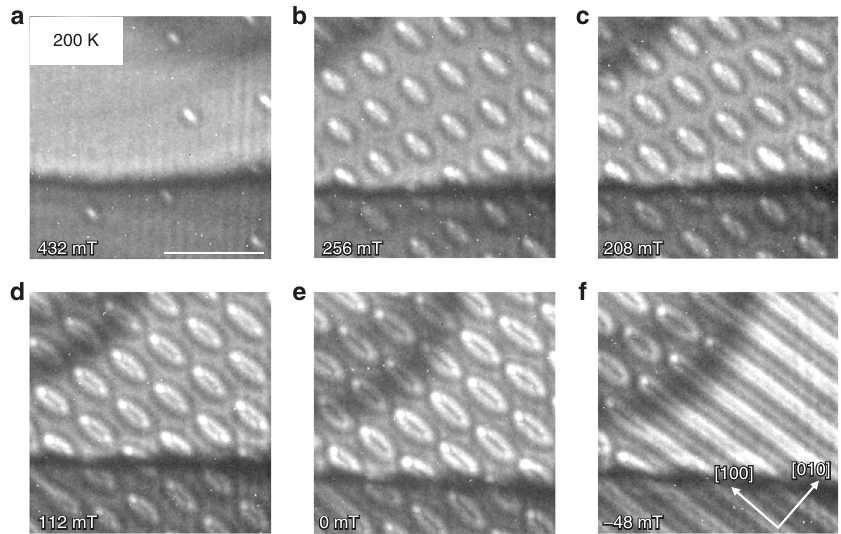
Fig. 3 Formation of elliptical skyrmions. The fi gure shows the evolution of the LTEM contrast with decreasing fi eld applying the modi fi ed experimental protocol (applying reversible tilting along [1 1 0] at high fi elds until a lattice of objects has formed) at the temperature of 200 K. Elliptic objects are observed that are identi fi ed as elongated Bloch skyrmions. One observes a few skyrmions at high fi elds ( a ) and then a transition to a densely packed array of skyrmions ( b – e ), which transforms into the helical phase only at negative fi elds ( f ). The black horizontal line in each LTEM image corresponds to bending contours. The scale bar corresponds to 500 nm.